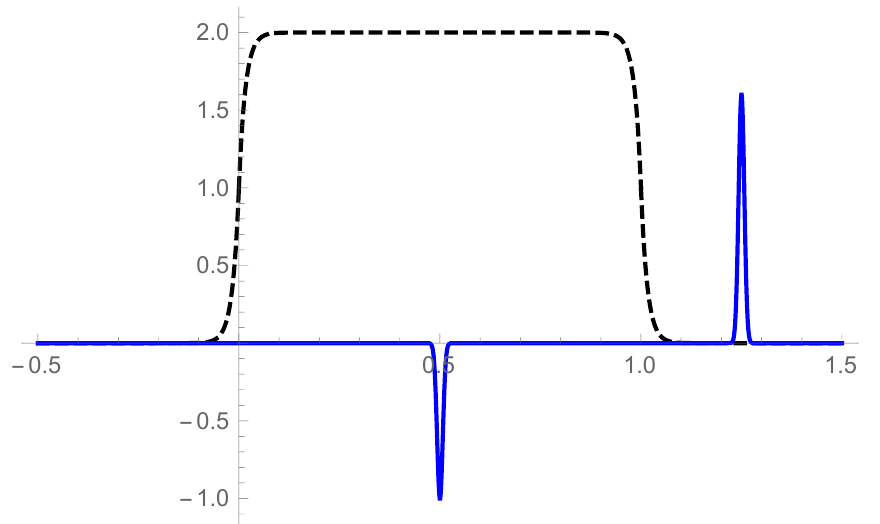
Figure 5 . Constraints to the negative energy allowed in a CFT. In this situation, the l.h.s. of equation (3.22) will be twice the total negative energy. For the inequality (3.22) to hold, it is necessary that the total negative energy of the pulse is